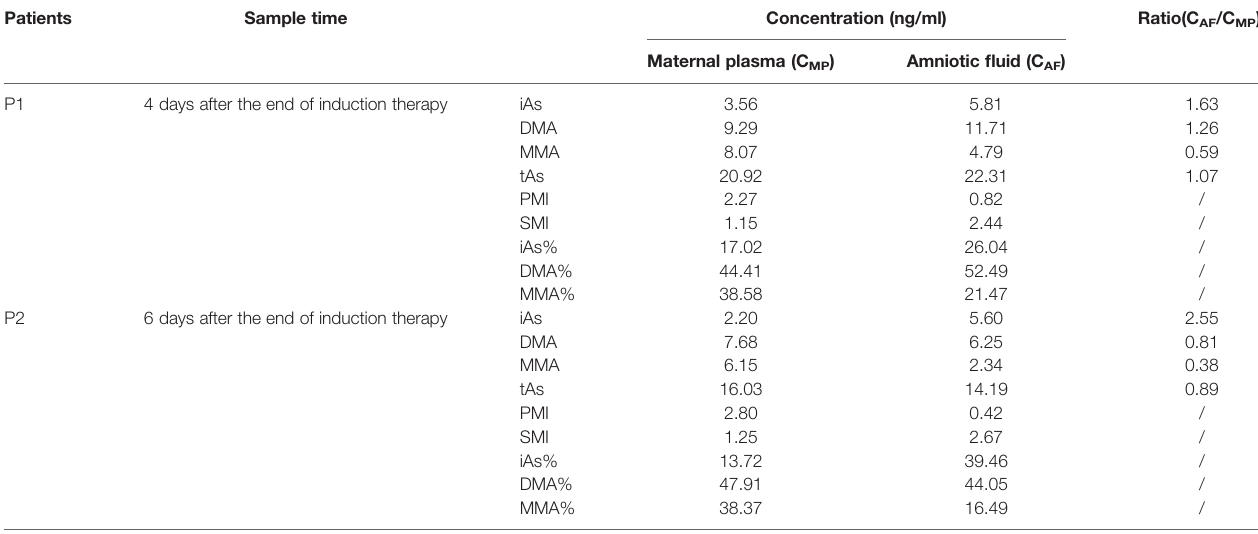
TABLE 3 | Arsenic species in amniotic fl uid (AF) and maternal plasma of APL patients treated with arsenic trioxide in pregnancy. Patients Sample